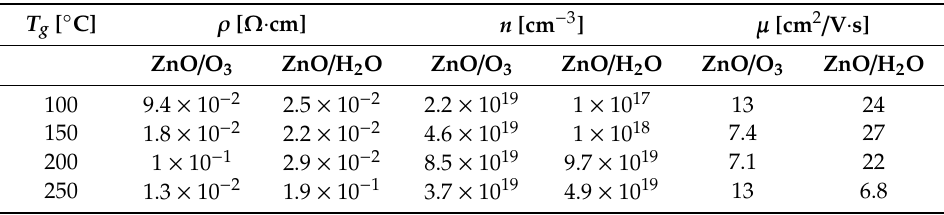
Table 3. Electrical parameters of investigated ZnO water-based and ozone-based samples: resistivity ( ρ ), carrier concentration ( n ), carrier mobility ( µ ); after post-growth annealing in argon (5 min. 500 °C).